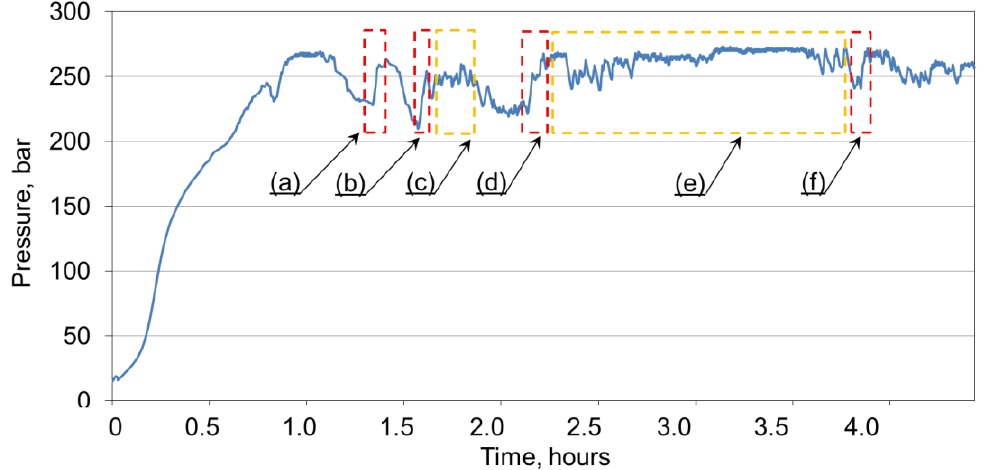
Figure 6. The four times ranges of pressure charging obtained to maintain the required working load capacity.